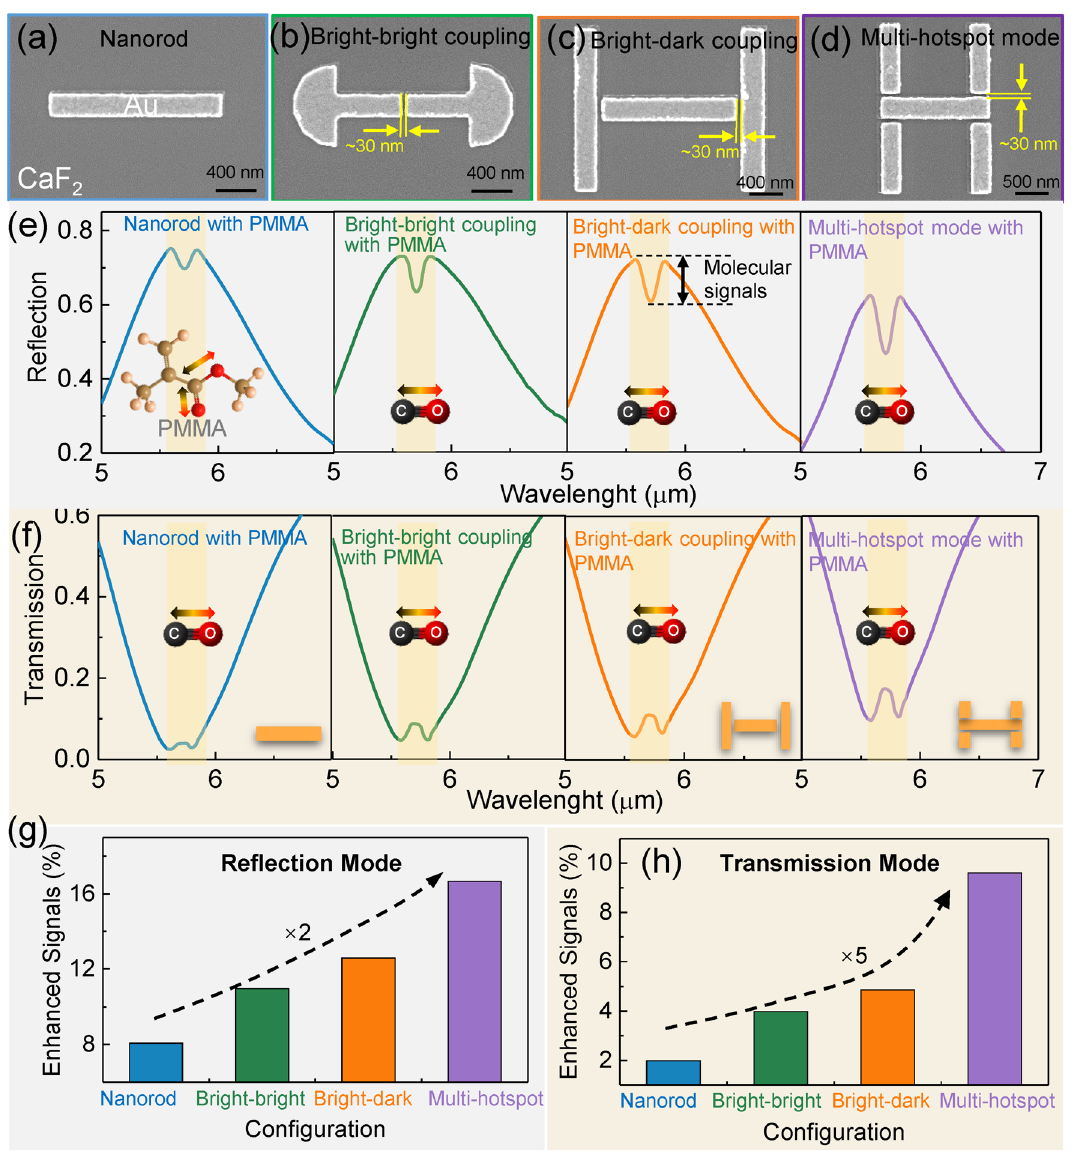
Fig. 4 Characterization of vibrational signal enhancement. a SEM images showing the details of nanorods, b bright–bright mode coupled antennas, c bright–dark mode coupled antennas, and d multi-hotspot bright–dark mode coupled antennas. All nanogaps size is set as 30 nm. e Measured reflection and f transmission spectra of the above-mentioned nanoantennas with 40-nm-thick PMMA as analytes. g Corresponding enhanced molecular signal of the above-mentioned nanoantennas extracted from reflection or h transmission